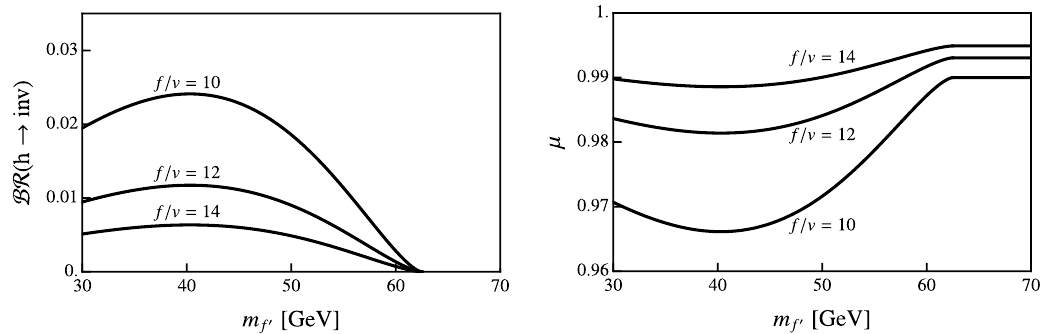
Figure 4 . Higgs-to-invisible branching ratio (left) and Higgs signal strength (right) as a function of m f 0 for various f=v